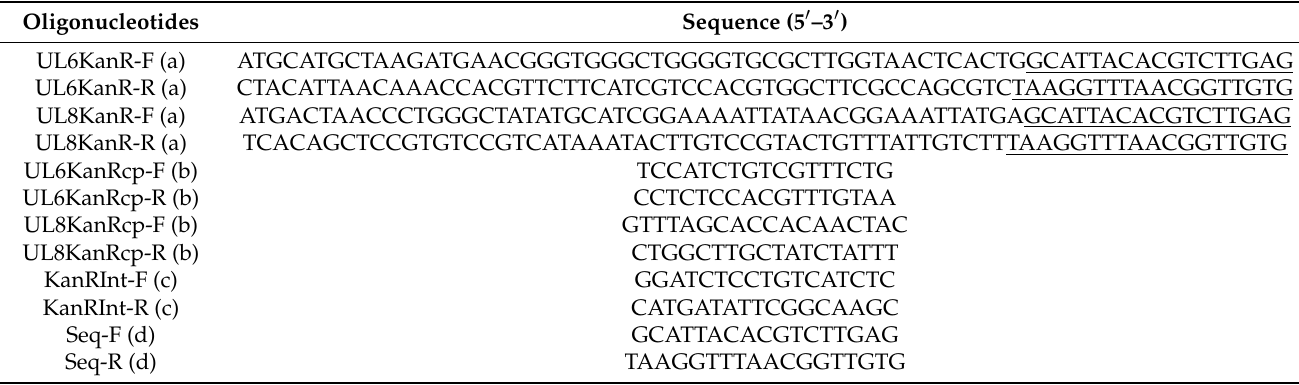
Table 2. Oligonucleotides used for amplification of Kanamycin resistance gene and mutant validation. Oligonucleotides